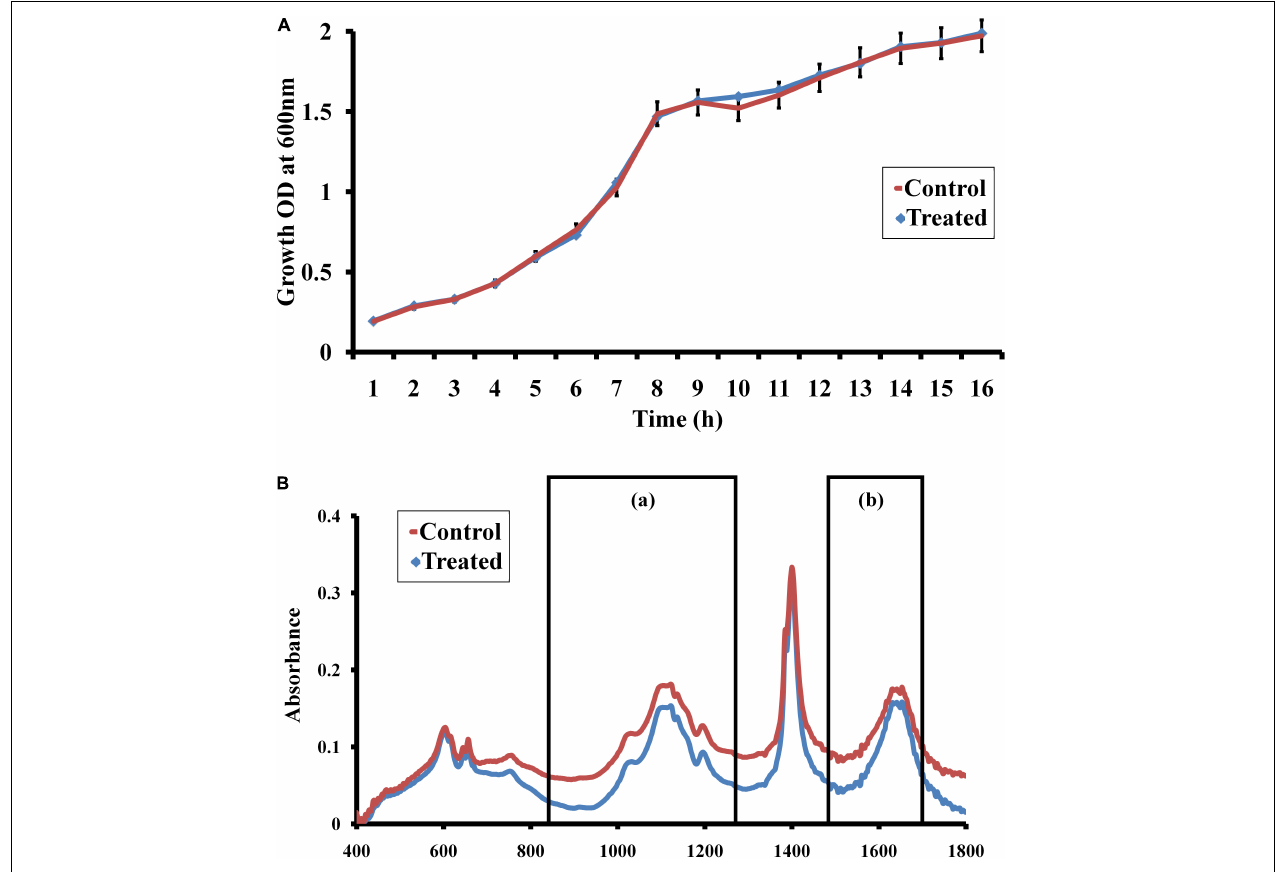
FIGURE 3 | (A) Growth curve analysis. The graph represents the effect of morin (at MBIC) on the growth dynamics of C. albicans . (B) FTIR spectra of EPS samples extracted from morin-treated (at MBIC) and untreated C. albicans . FT-IR spectra showed variations in regions such as (a) mixed regions of polysaccharides and